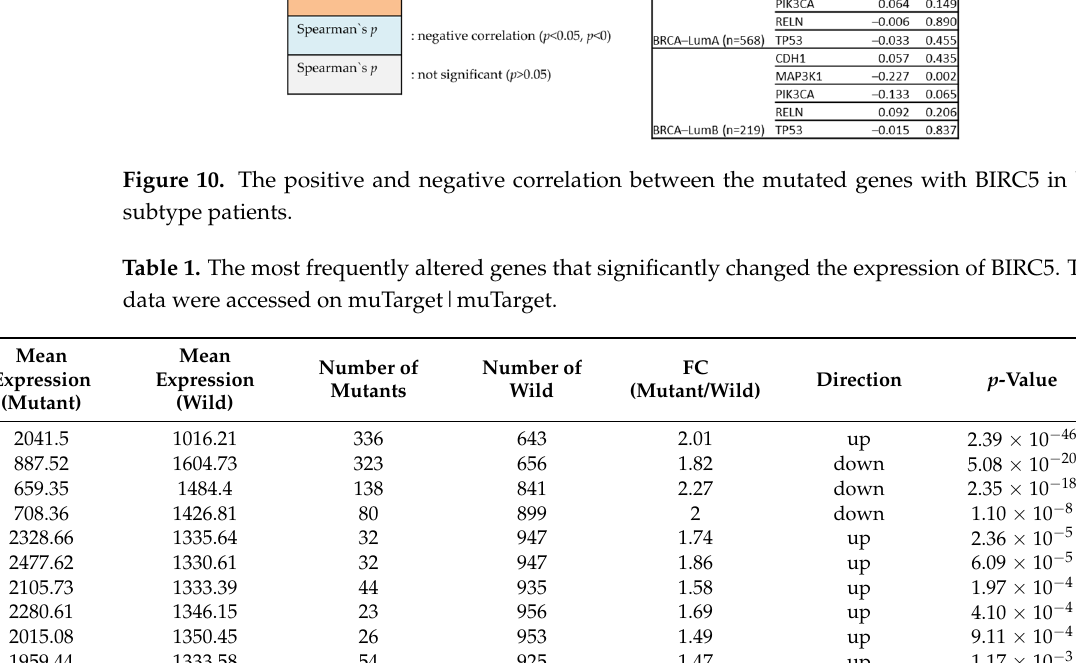
Table 1. The most frequently altered genes that significantly changed the expression of BIRC5. The data were accessed on muTarget|muTarget.